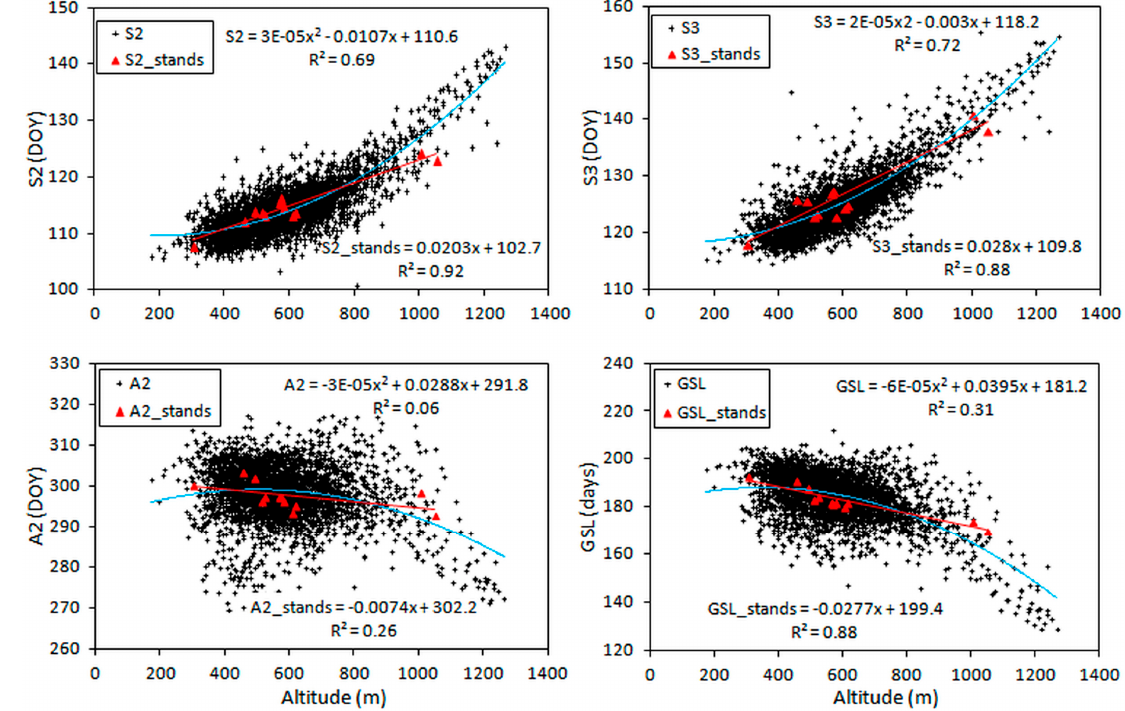
Figure 8. Satellite-based phenological metrics S2 ( a ), S3 ( b ), A2 ( c ), and growing season length, GSL ( d ) as a function of altitude at a stand-level and large-scale level. The individual phenological metrics of 12 study stands are indicated by red triangles and the altitudinal trend is the linear red line. The phenological metrics derived from all beech-dominated stands (60% of beech and higher) in the area of Slovakia are indicated by black crosses and the altitude trend is the polynomial blue line. DOY, day of year. Table 4. The altitudinal gradient of the phenological metrics S2, S3, A2, and GSL calculated from regression functions for each 100 m of the vertical distribution range of beech-dominated pixels (from 156 to 1331 m a.s.l.). Values in the table were rounded to the whole day. Altitudinal Gradient of Large-Scale Phenology Difference on Altitudinal Gradient Altitude S2 A2